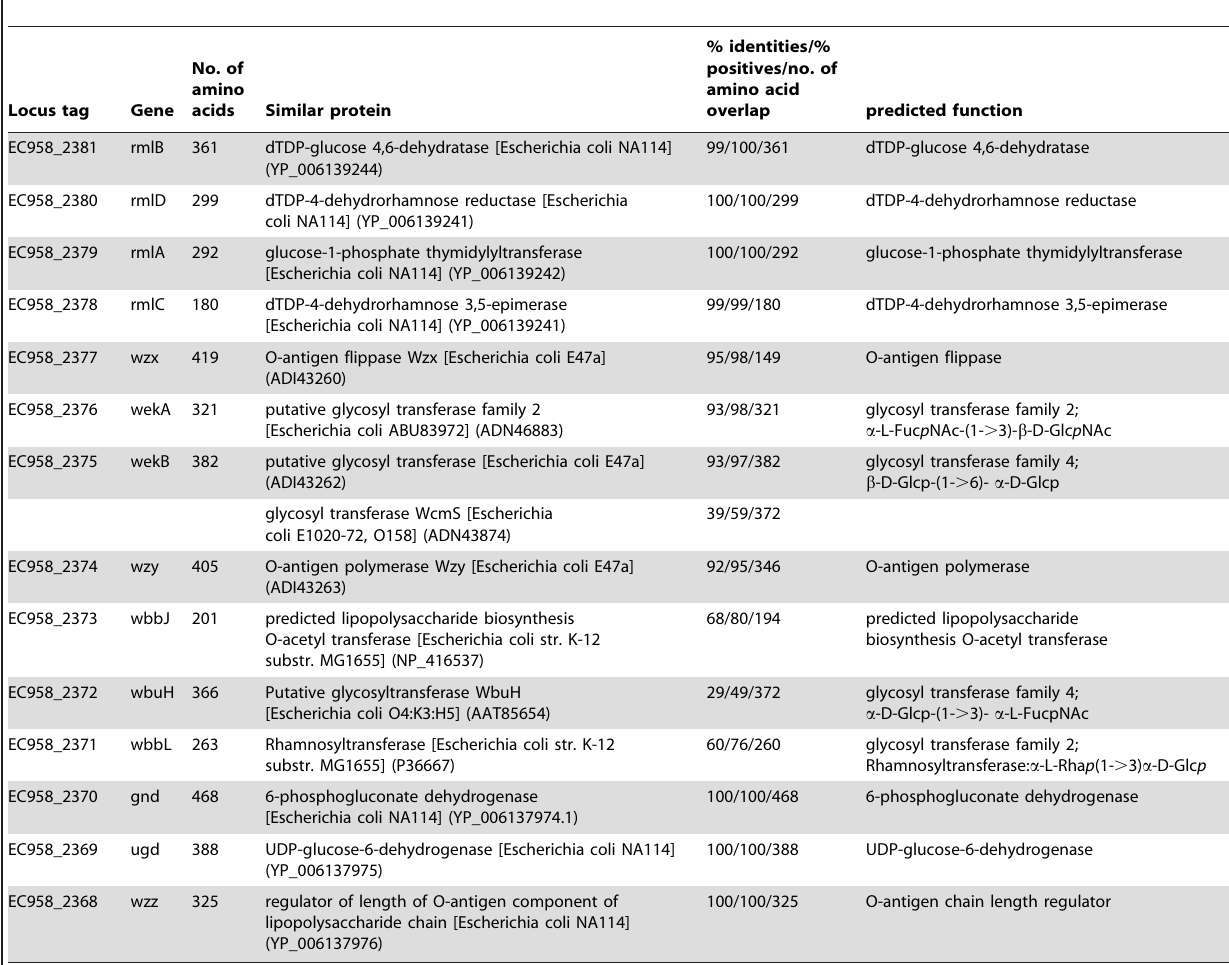
Table 3. Summary of E. coli EC958 O25b antigen biosynthesis genes.